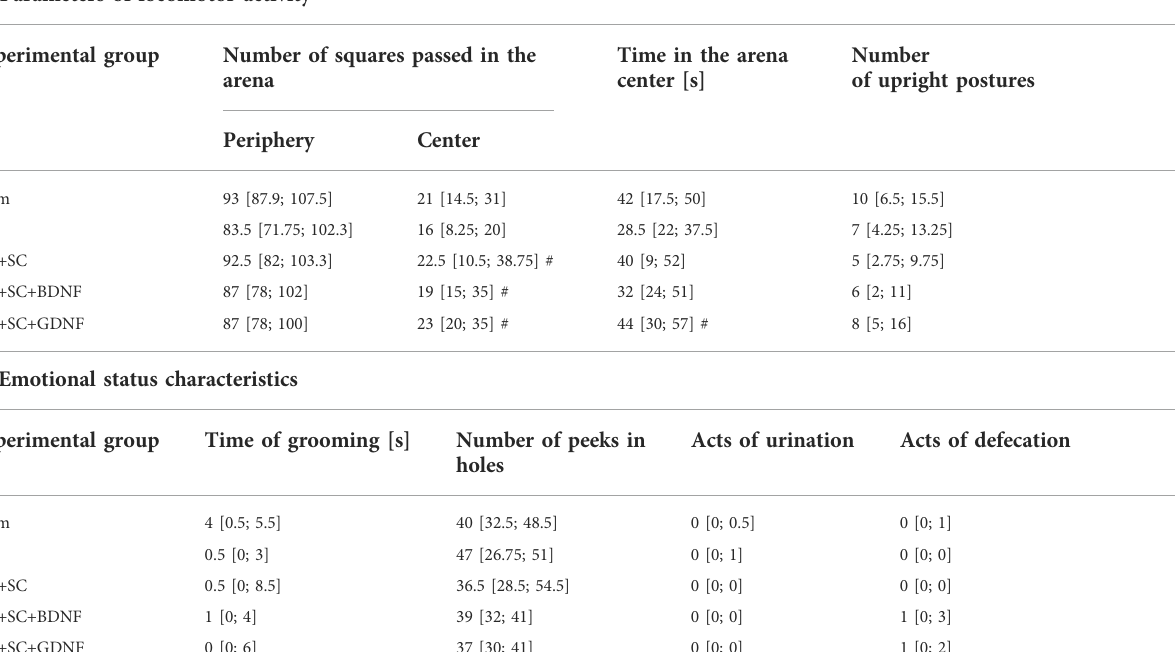
TABLE 3 Parameters of behavioral reactions of mice in the Open Field test on day 21 after scaffold implantation.